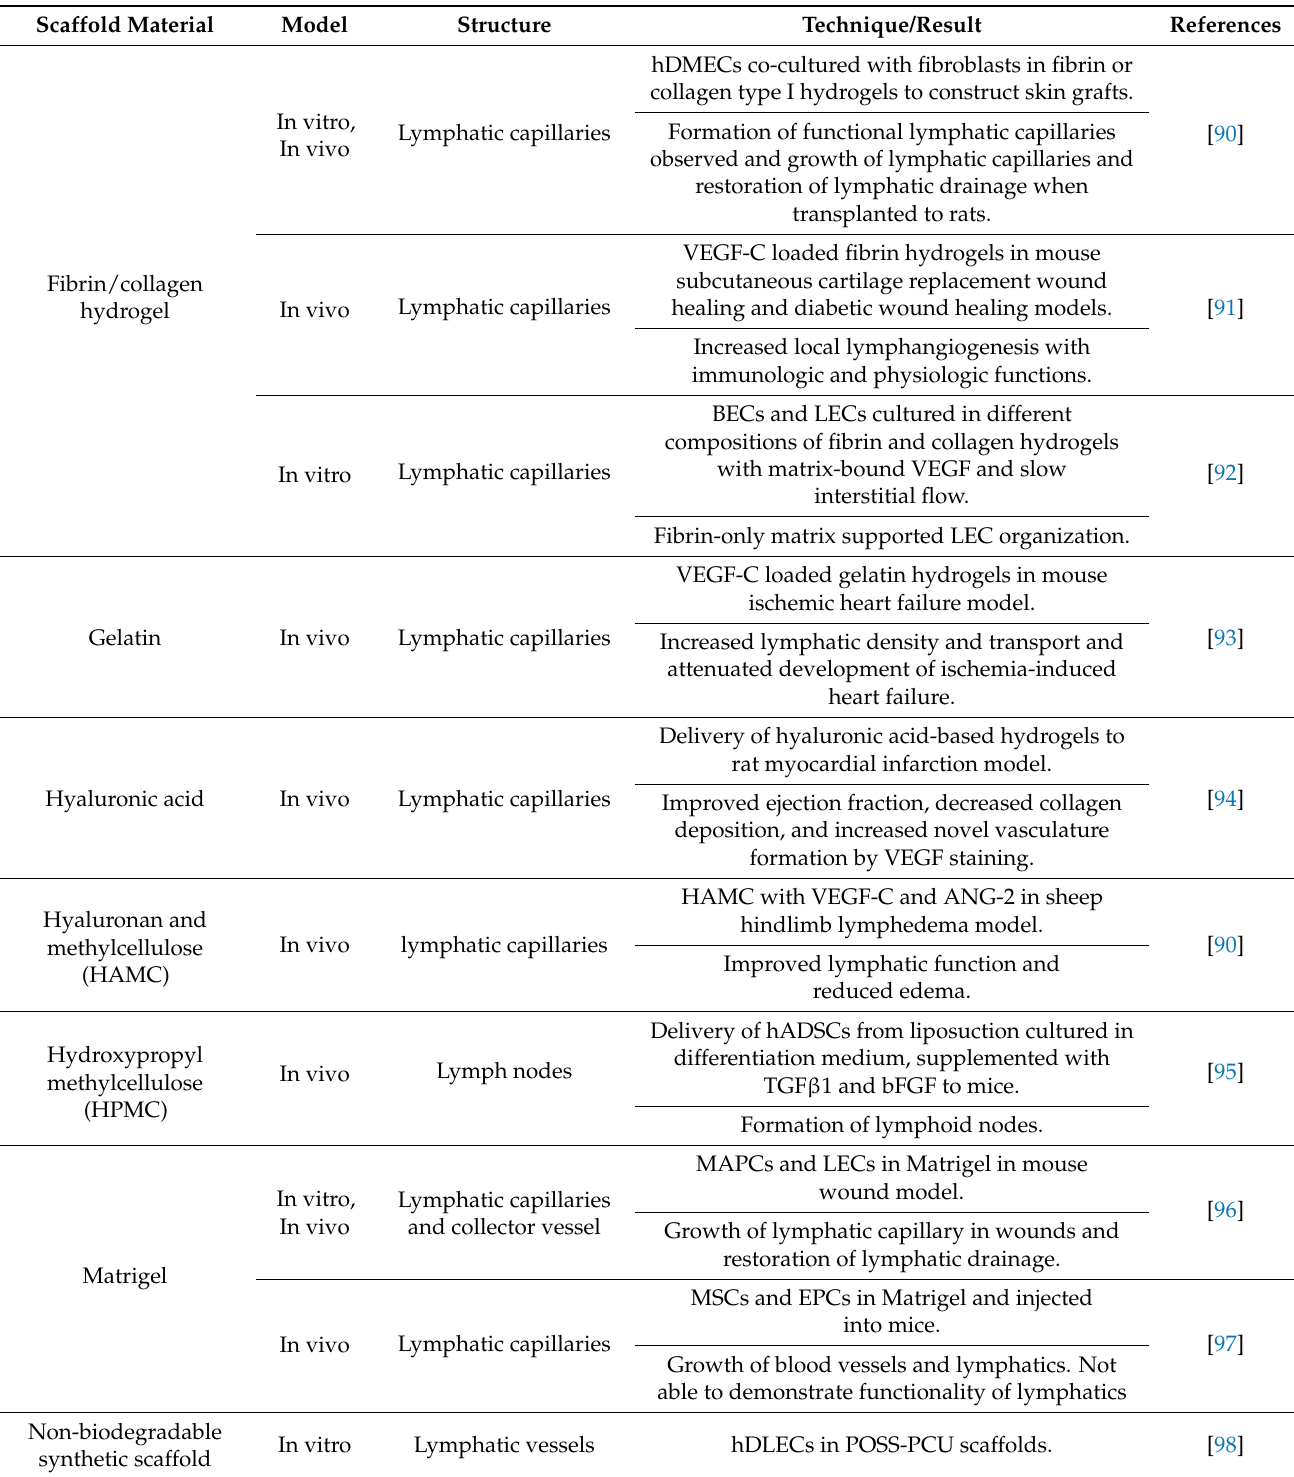
Table 1. Summary of 3D scaffold materials for lymphatic tissue